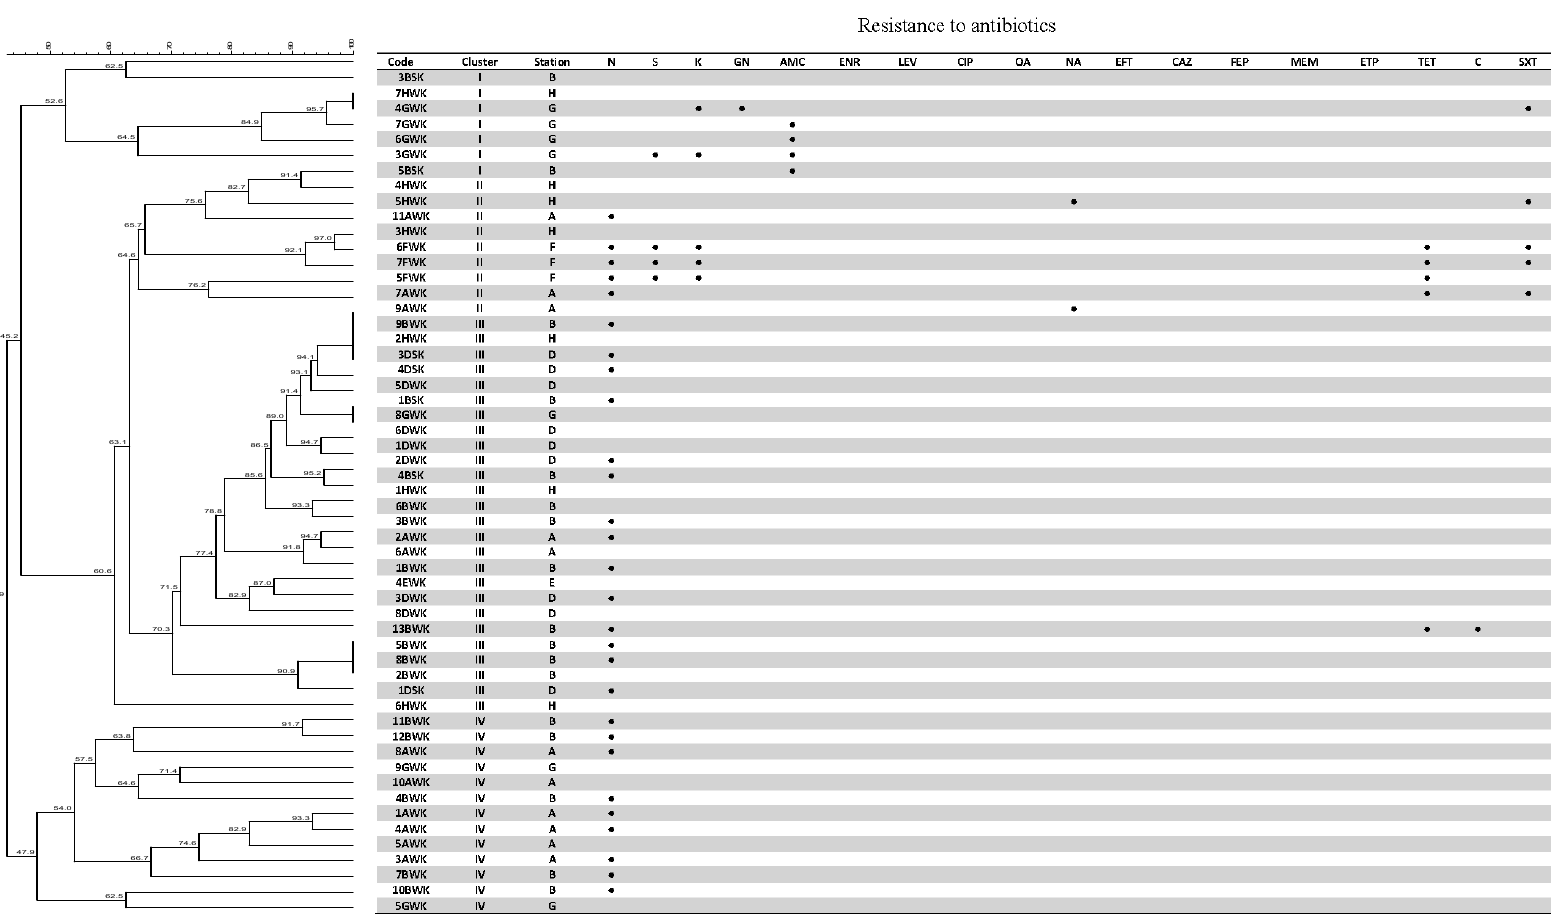
Figure 3. Dendrogram and table representing the resistance of K. pneumoniae isolates to the 19 types of antibiotics (N, neomycin; S, streptomycin; K, kanamycin; GN, gentamicin; AMC, amoxicillin/clavulanic acid; ENR, enrofloxacin; LEV, levofloxacin; CIP, ciprofloxacin; OA, oxolinic acid; NA, nalidixic acid; EFT, ceftiofur; CAZ, ceftazidime; FEP, cefepime; MEM, meropenem; ETP, ertapenem; TET, tetracycline; C, chloramphenicol; SXT, trimethoprim-sulfametoxazol). The dendrogram was constructed using the Bionumerics version 6 software.